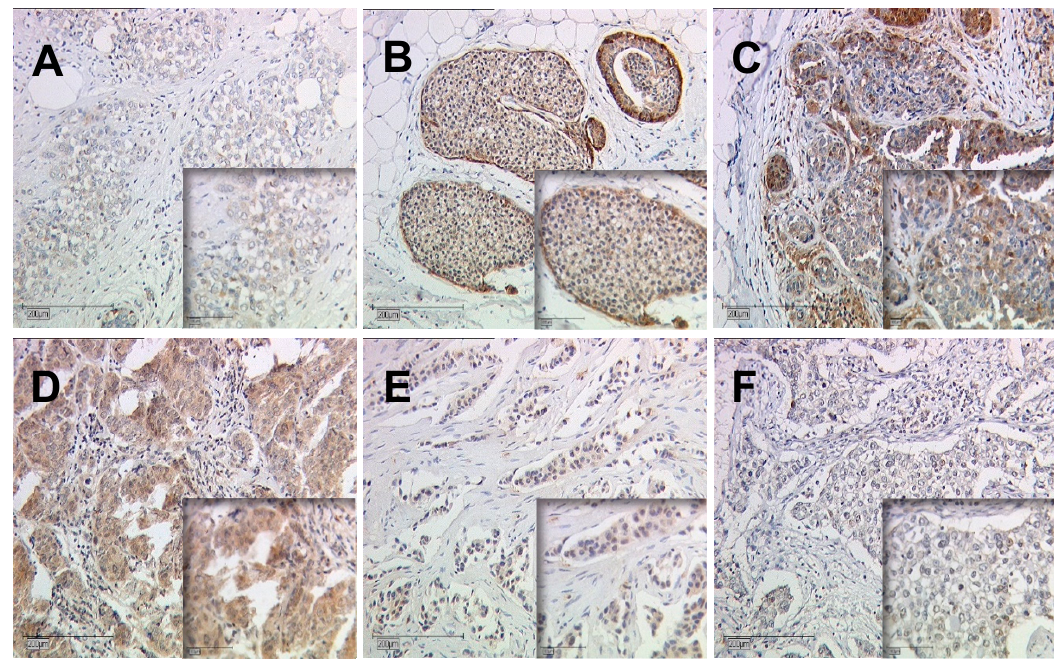
Figure 2. Gal-7 and Gal-8 expression dependent on tumor grading. Exemplary immunohistochemical staining of Gal-7 in grade 1 ( A ), 2 ( B ), and 3 ( C ) tumors and of Gal-8 in grade 1 ( D ), 2 ( E ), 3 ( F ) tumors are shown. Magnification: main images x10, image sections x25.